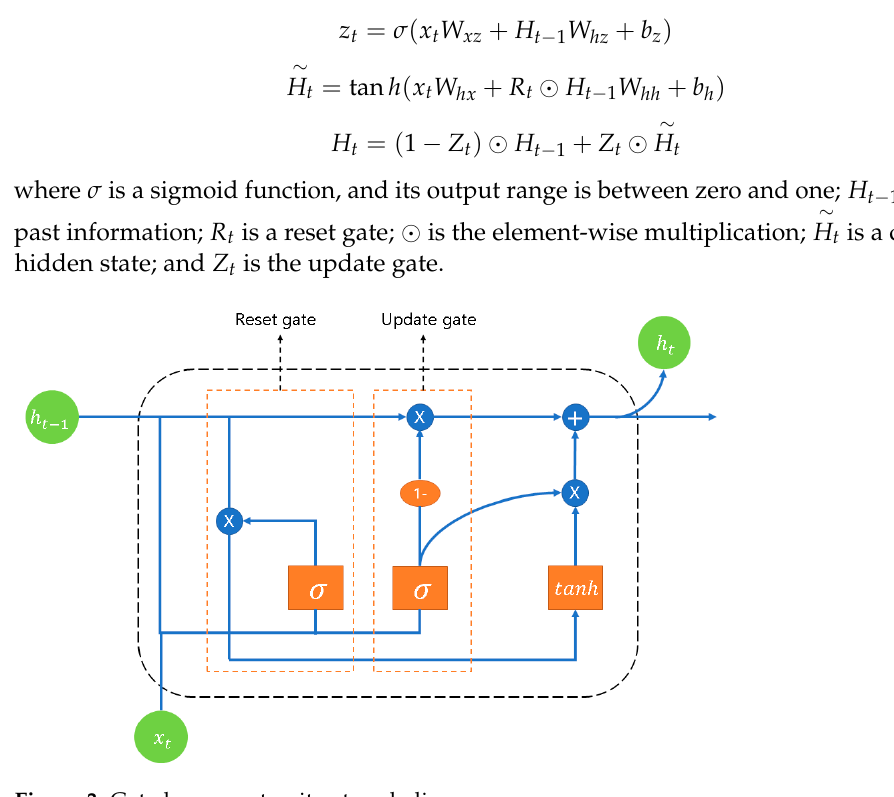
Figure 2. Long short-term neural network diagram.